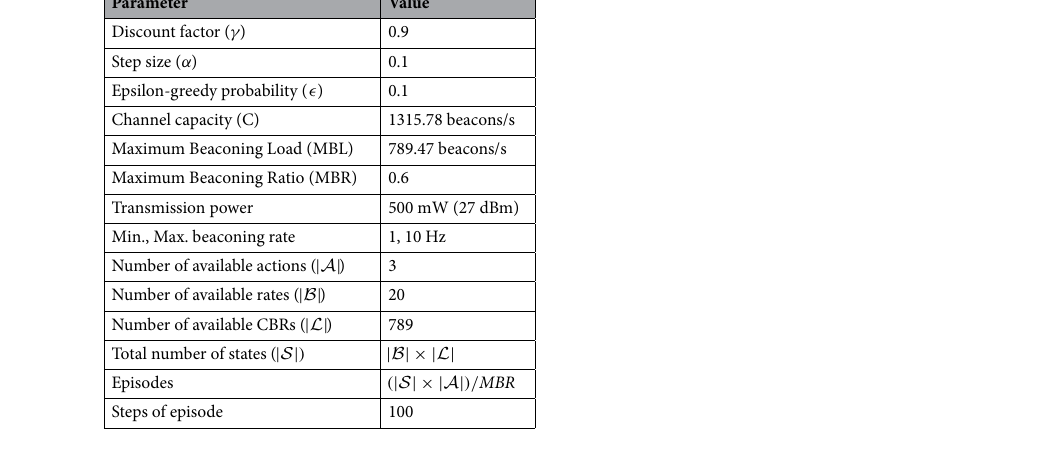
Table 1. Training parameters and their